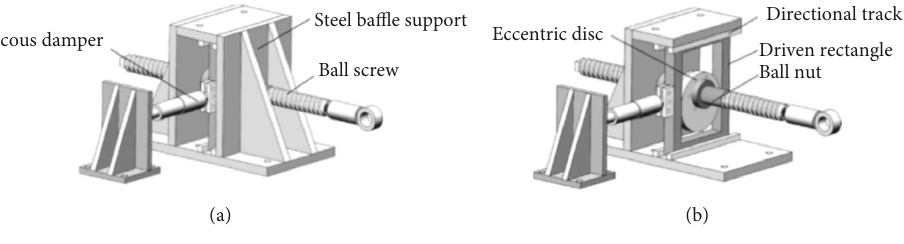
Figure 1: Schematic diagram of